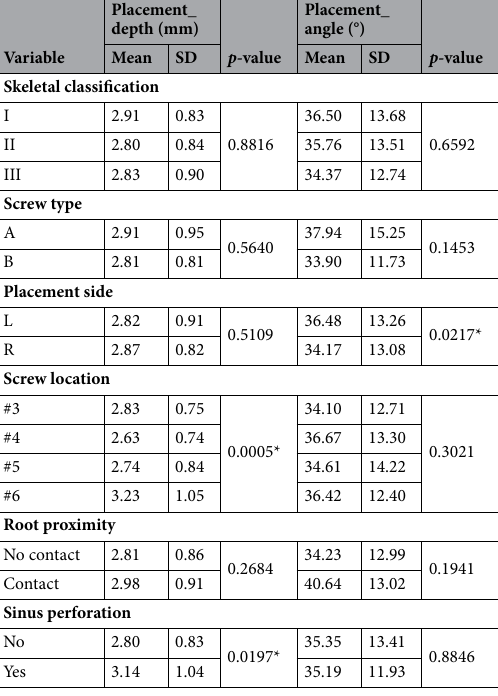
Table 3. The mean values and standard deviations of placement depth and placement angle according to each variable. L left, R, right; #3 Canine, #4 1st premolar, #5 2nd premolar, #6 1st molar. * p < 0.05.